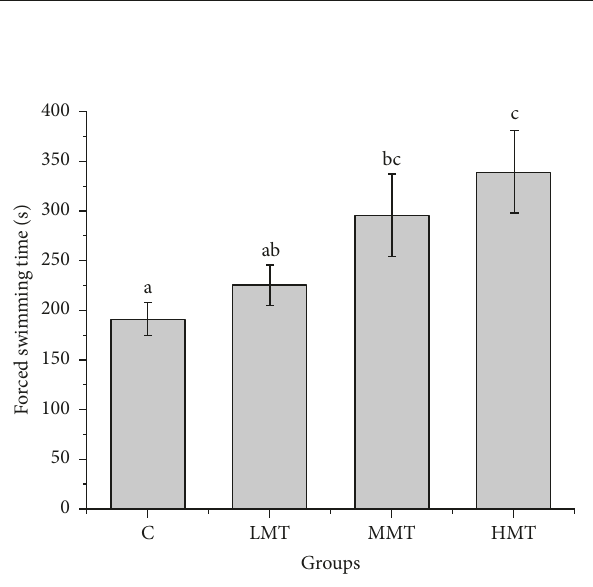
Figure 2: Effect of Xinjiang maca on blood lactic content (C, control; LMT, low-dose maca-treated group; MMT, medium-dose maca-treated group; HMT, high-dose maca-treated group. Each value represents the mean ± SD ( 𝑛 = 10 ). Different letters indicate significant differences among groups ( 𝑃 < 0.05 )).